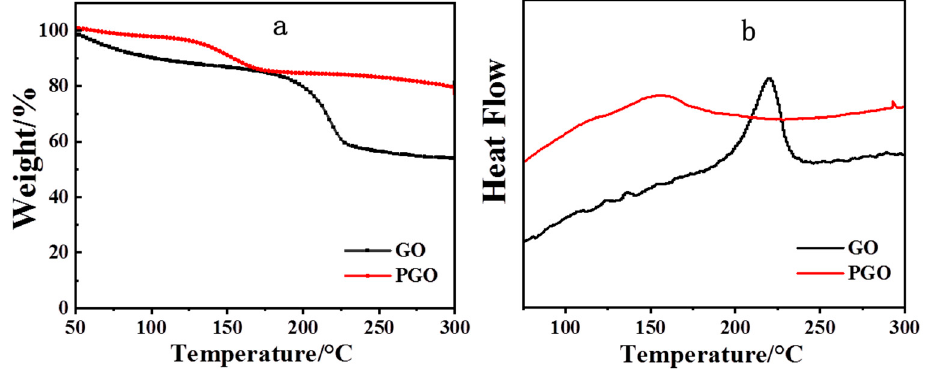
Figure 3. TGA( a ) and DSC ( b ) curves of GO and PGO.